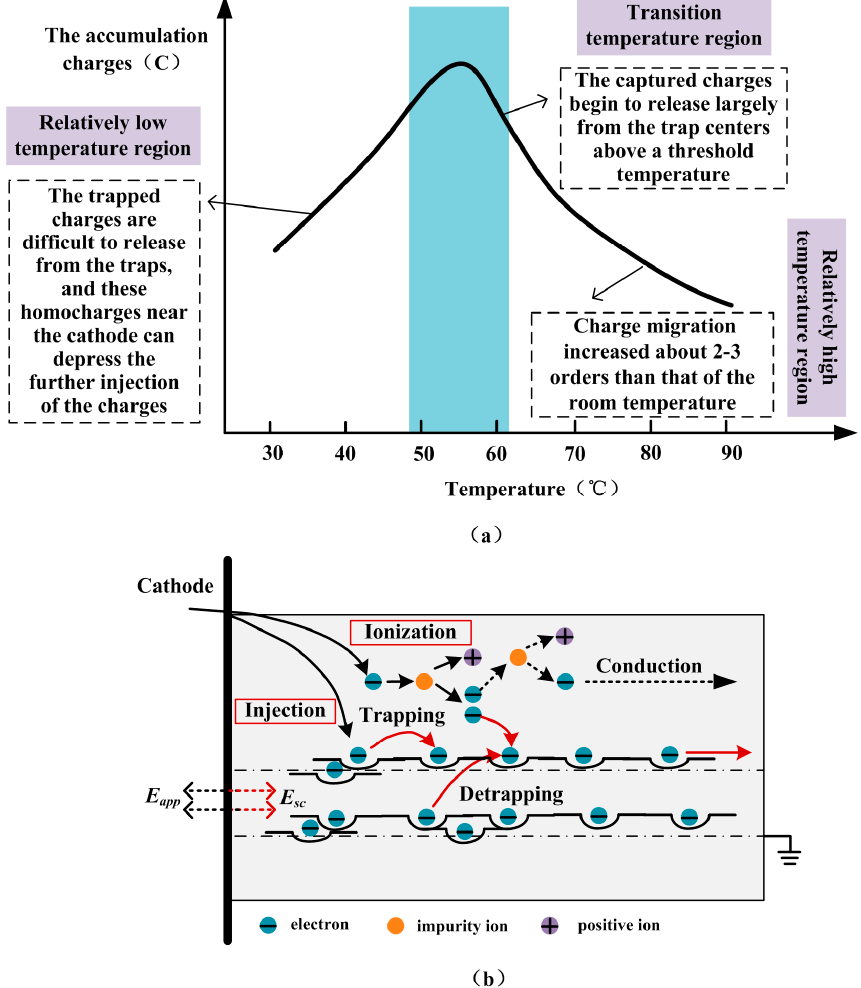
Figure 6. Schematic diagram of the charge accumulation dependence on the polarization temperature. ( a ) The change in trend of the accumulation charges in polymer with the temperature; ( b ) the dynamic processes of charge generation and dissipation in polymer.